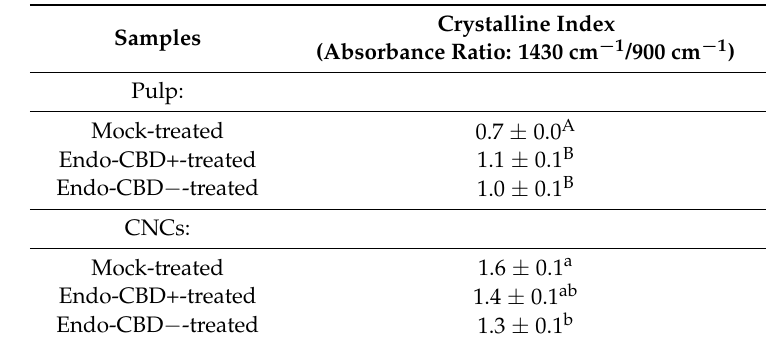
Table 1. FTIR assessment of crystallinity index of mock-treated or endoglucanase-treated (1.0 U/g of pulp) wood pulp and resulting CNCs generated through acid hydrolysis.